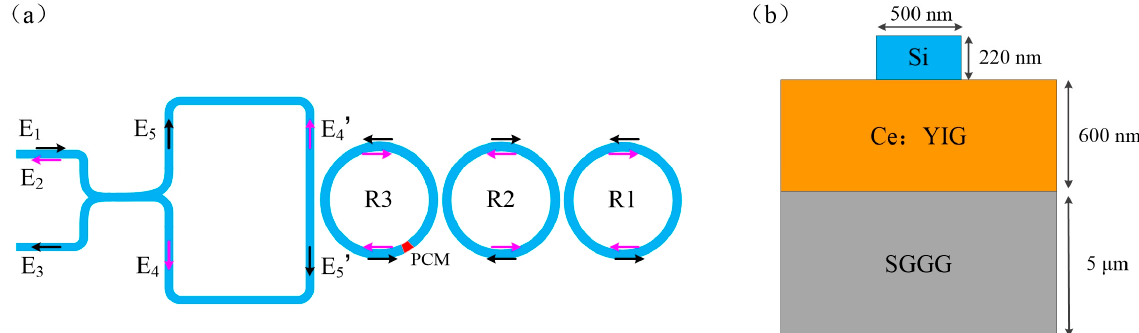
Figure 1. ( a ) Structure of optical buffer based on Sagnac ring coupled 1 × 3 MOMRs; ( b ) Section diagram of waveguide.